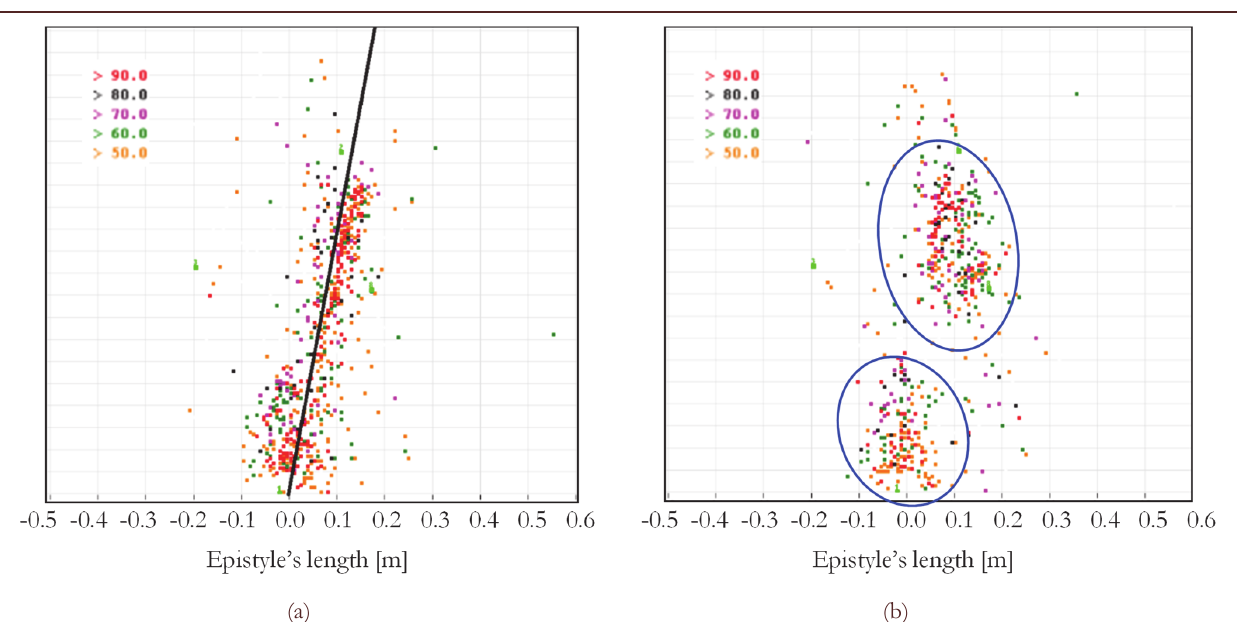
Figure 14: The spatial distribution of acoustic events for the second (a) and third (b) time intervals